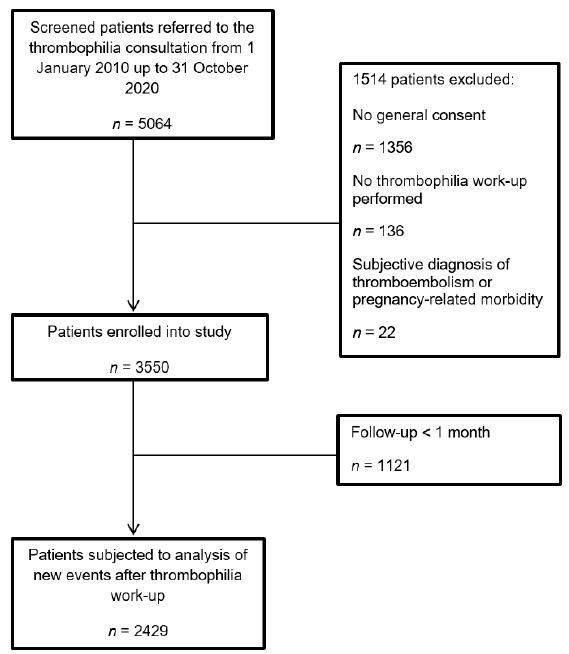
Figure 1. Flow diagram of patients.